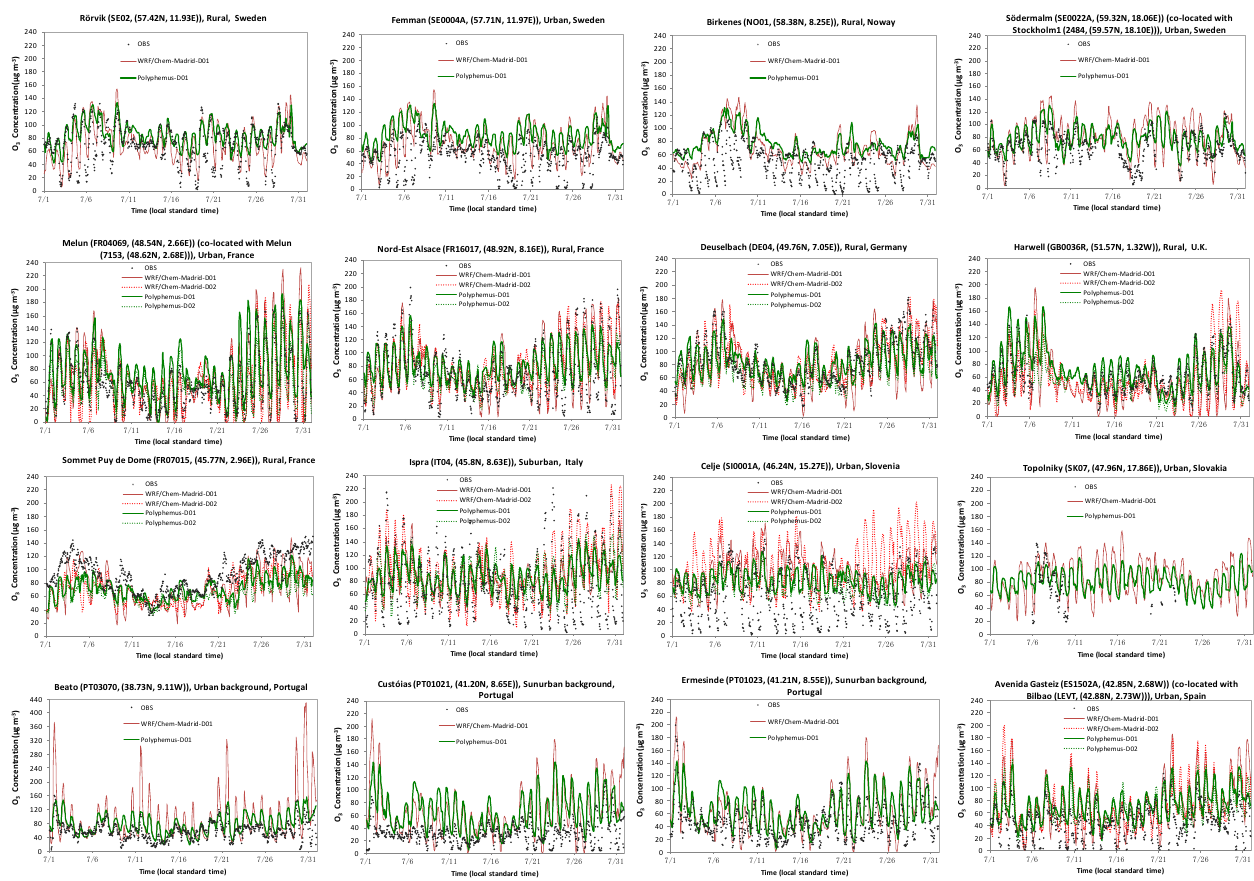
Figure 5. Simulated and observed concentrations of hourly O 3 in July 2001 at selected sites over D01 and D02 in four latitude bands: 57-60 ºN, 48-52 ºN, 45-48 ºN, and 38-43 ºN (rows 1, 2, 3, and 4, respectively).